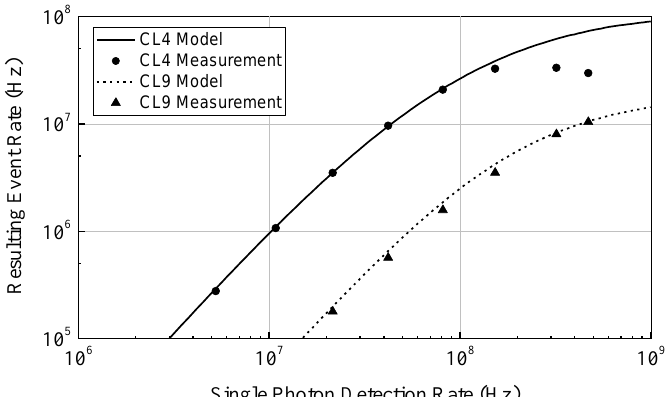
Figure 9. Theoretical coincidence model versus measurement. For a low number of active SPADs and short coincidence time (CL9), the influence of the detection circuits is small and a good agreement is achieved. If more SPADs are used and the coincidence time is close to the dead time (CL4), the measured event rates saturate at higher photon detection rates due to the detection